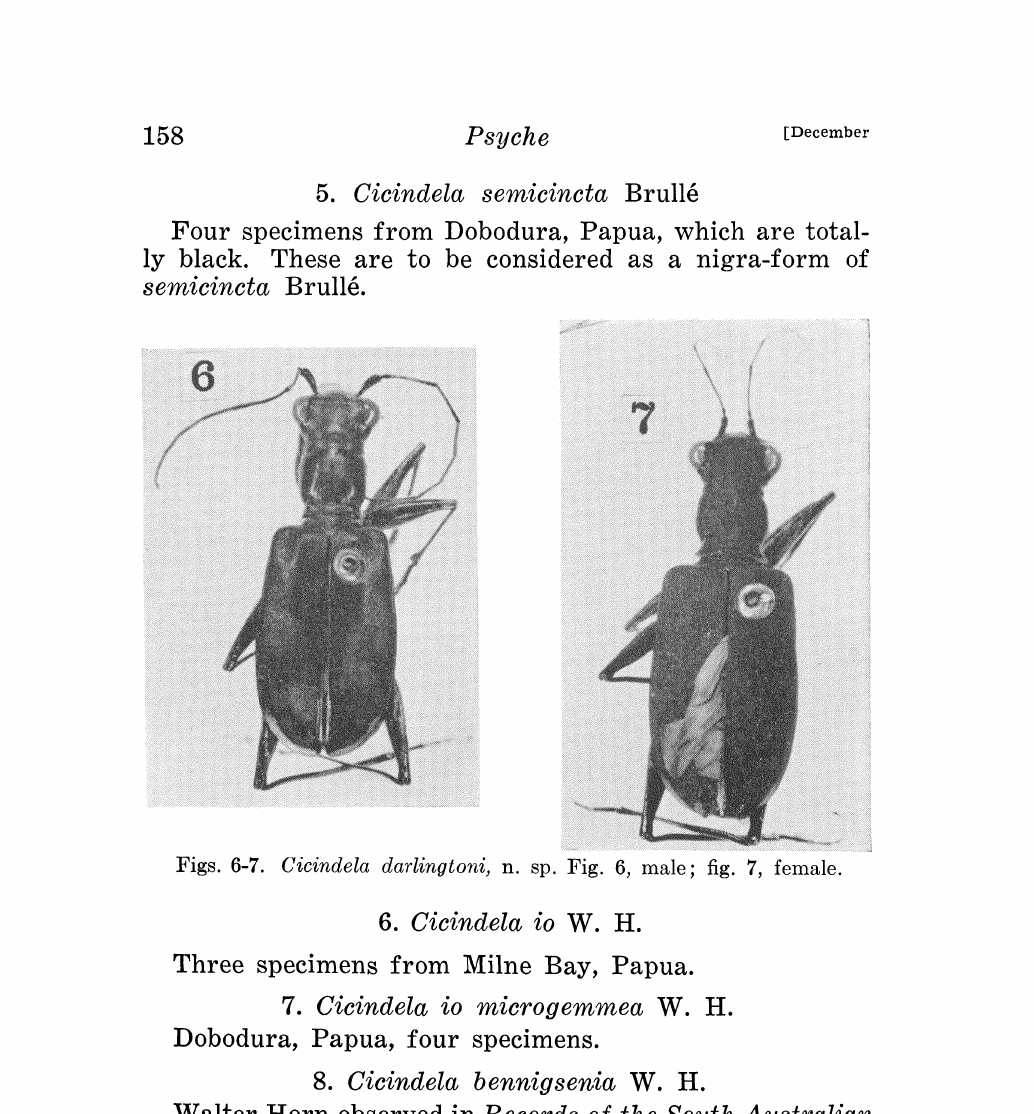
Figs. 6-7. Cicindela darlingtoni, n. sp. Fig. 6, male; fig. 7, female. 6. Cicindela io W.